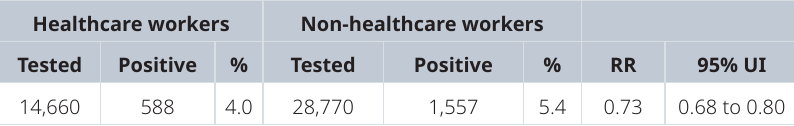
Table 2. Relative COVID-19 incidence rate (RR) and counts of healthcare workers and non-healthcare workers and their crude counts and rates.